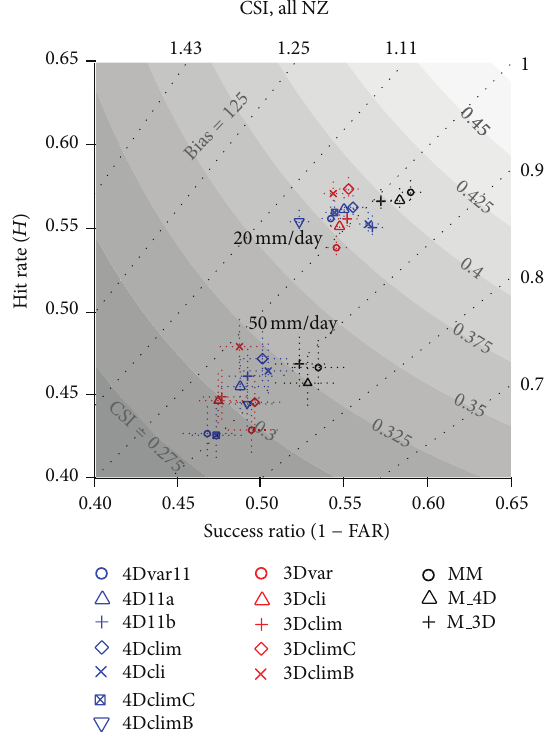
Figure 6: Performance diagram comparing mod-heavy and heavy rainfall for all of NZ. CSI is shown by the shaded contours and bias by the grey dotted lines. The dotted uncertainty bars show the one standard deviation error in hit rate and success